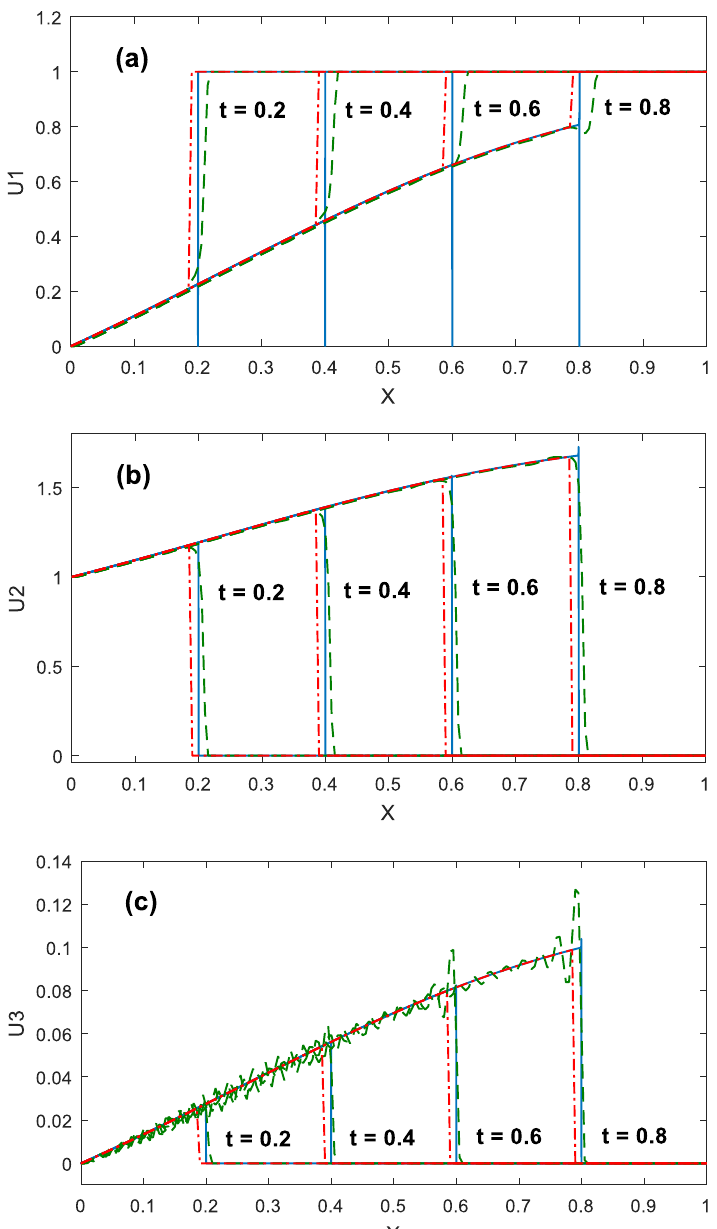
Figure 4. Comparisons of numerical methods for autocatalytic reaction model with three-component reactants at four time levels with V = 1. Concentration distribution along the reactor for (a) species A (b) species B and (c) species C. Solid line: reference, dash line: MTVDLF-Superbee and dash-dot line: Lagrangian particle.